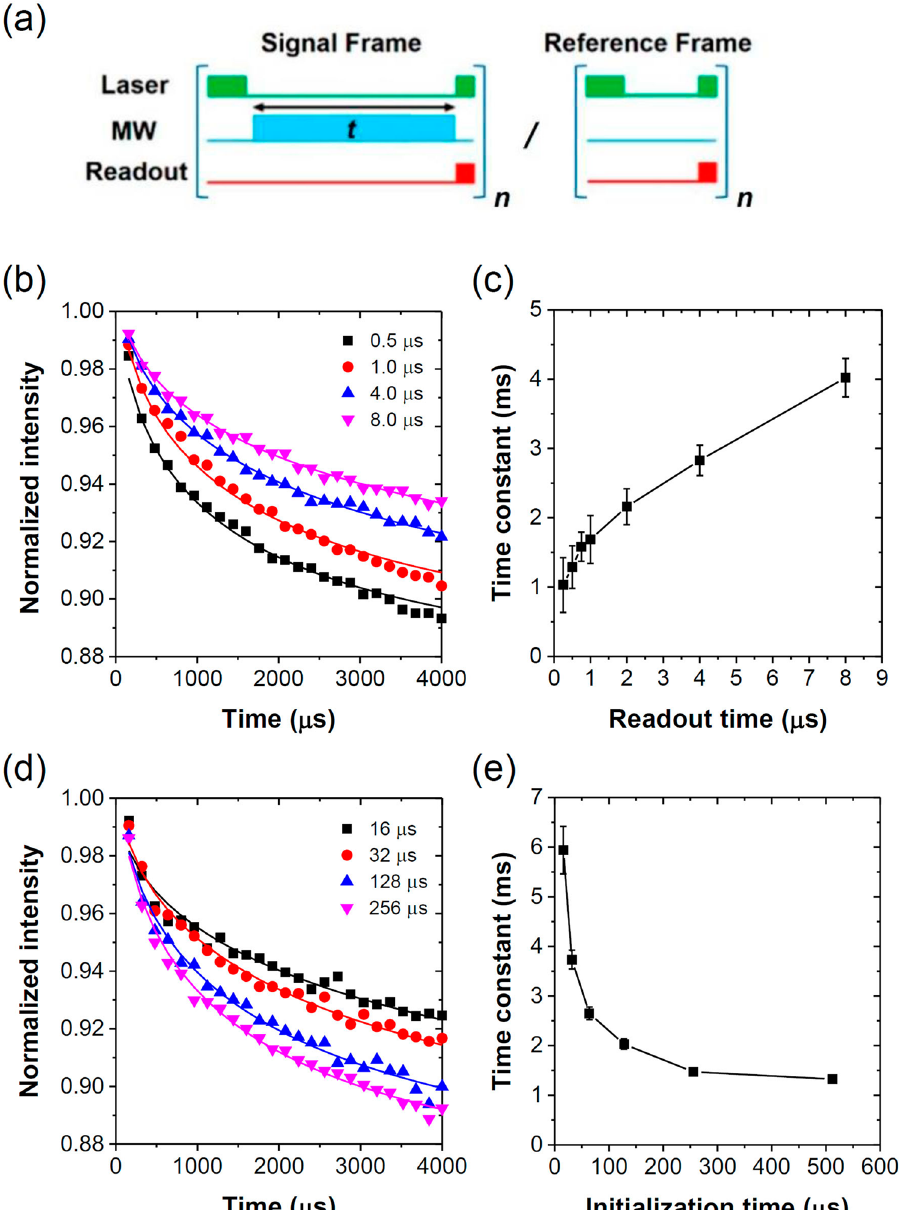
Figure 4. ( a ) Pulse sequences for relaxation measurements. A signal frame with variable delay time t was followed by a fixed delay reference frame. MW irradiation was applied during the variable delay time t in between laser pulses for Rabi/driven relaxation experiments, while MW was absent during the variable delay time t in between laser pulses for MW-free depolarization experiments. Normalization of signals was achieved by dividing a signal frame to its follow-up reference frame. ( b ) Depolarization measurements made with different durations of readout pulses. The normalized signals were fitted with a stretched-exponential function to obtain the decay time constant T off . ( c ) Measured depolarization decay time constant T off as a function of readout time. The length of the initialization pulses in ( b ) and ( c ) is 300 μs. ( d ) Depolarization measurements made with different durations of initialization pulses. The normalized signals were fitted with a stretched- exponential function to obtain the decay time constant T off . ( e ) Measured depolarization decay time constant T off as a function of initialization time. The length of the readout pulses in ( d ) and ( e ) is 0.5